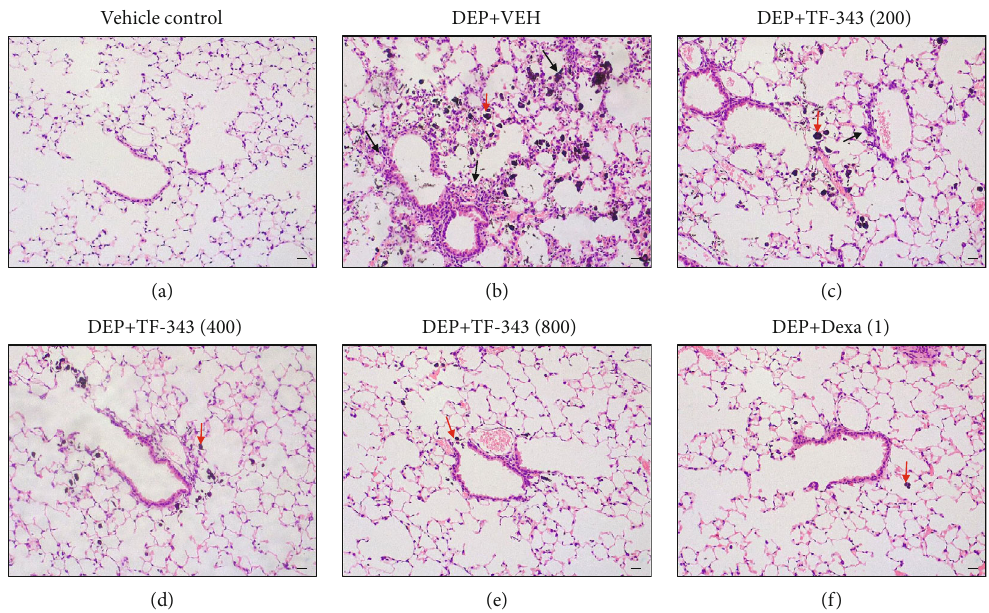
Figure 4: Histological changes in lung tissue caused by DEP treatment. Representative H&E-stained sections of the lung obtained from mice treated with (a) vehicle or (b-f) DEP alone (b) or in conjunction with TF-343 at 200mg/kg (c), 400mg/kg (d), or 800mg/kg (e) or Dexa (1 mg/kg) (f). Red and black arrows indicate black particle-laden alveolar macrophages and in fl ammatory cells, respectively. Scale bars, 20 μ